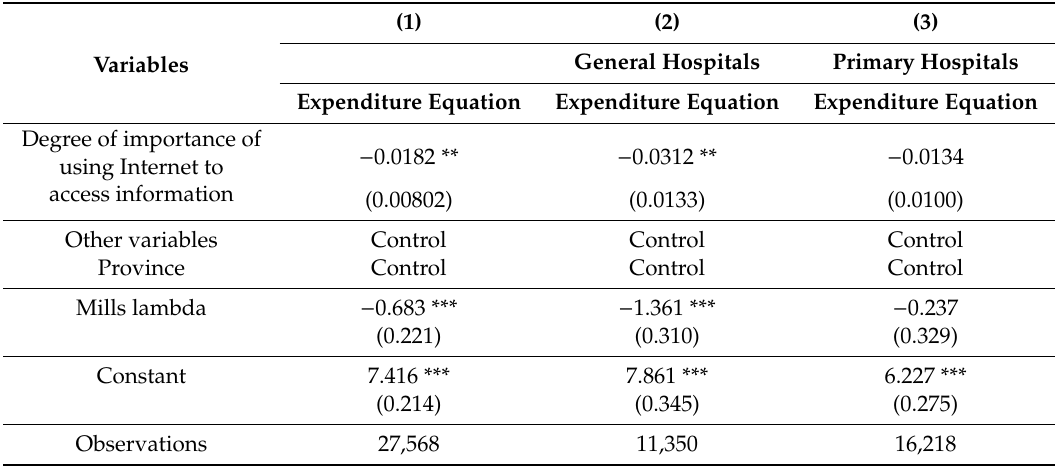
Table 4. Impact of the importance of using Internet to obtain information on individuals’ medical expenditure among di ff erent hospital